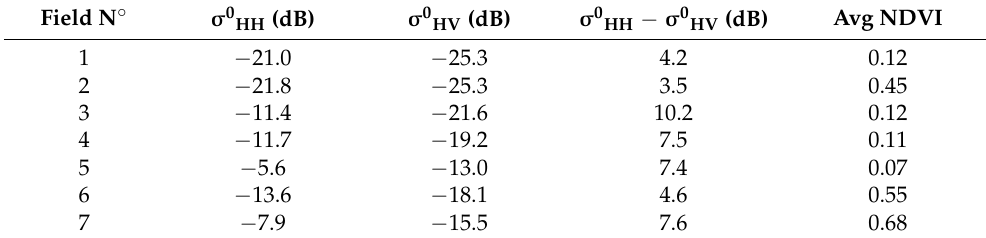
Figure 5. Same as Figure 2 (( a ), ( c ), ( e ), ( g ), ( i ), and ( k )) and Figure 3 (( b ), ( d ), ( f ), ( h ), ( j ), and ( l )) but zoomed in on fields selected in the CSG image acquired on 17 September 2022. Table 1. Mean values σ 0HH , σ 0HV , σ 0HH − σ 0HV , and NDVI in the fields shown in Figure 5. Field N